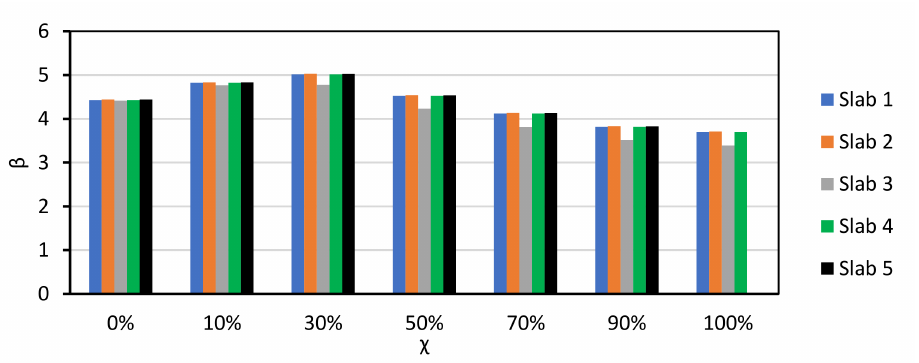
Figure 2. χ vs. β for shear resistance design of NAC slabs without shear reinforcement. prEN1992 [32]. γ NAC =